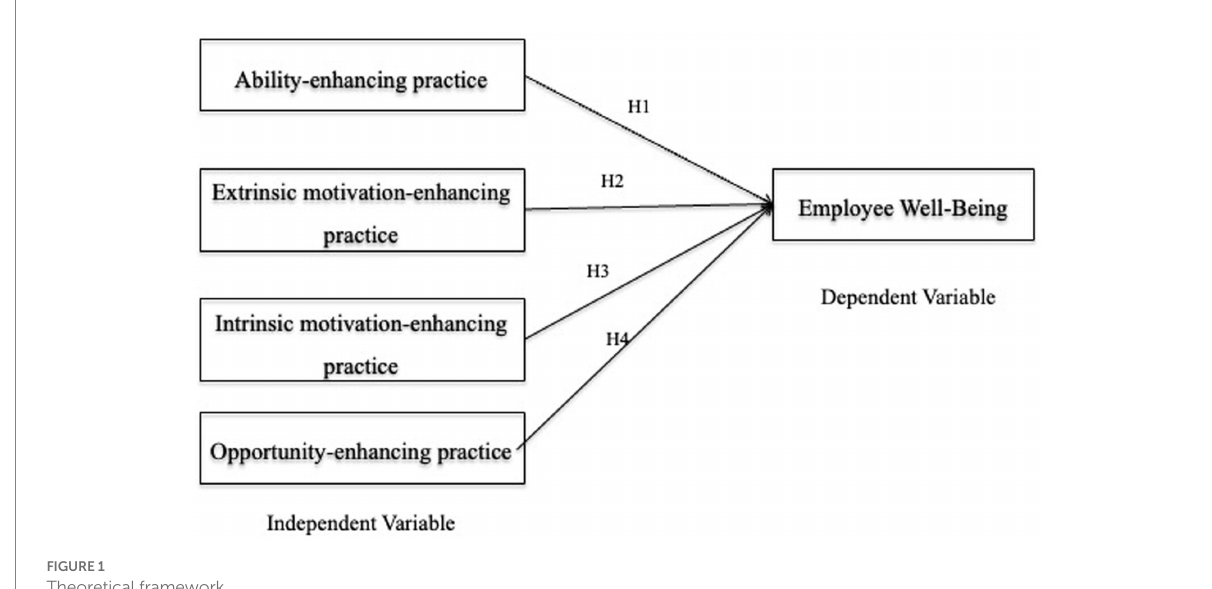
FIGURE 1 Theoretical